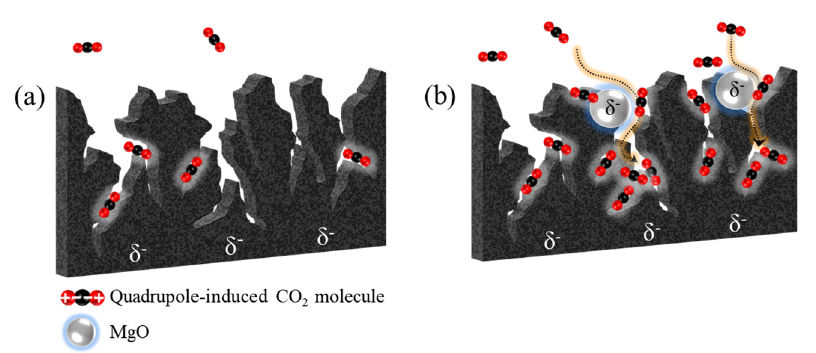
Figure 6. Schematic illustrations of the suggested CO 2 adsorption mechanism on ( a ) bare AC and ( b ) MgO-coated AC.